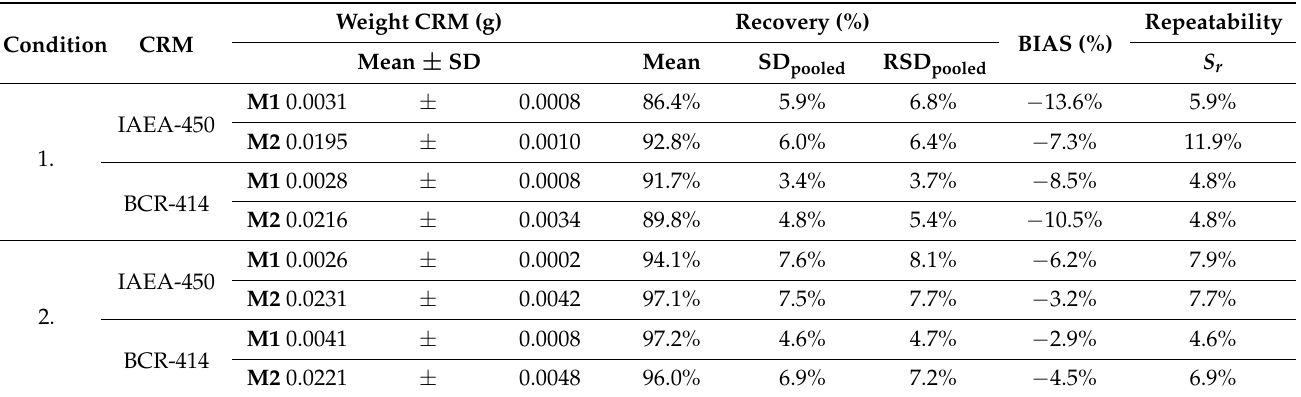
Table 1. Results of the analysis of the reference materials under the two procedures. Results describe the compilation of the different batches performed with recovery, precision, bias, and repeatability % of each